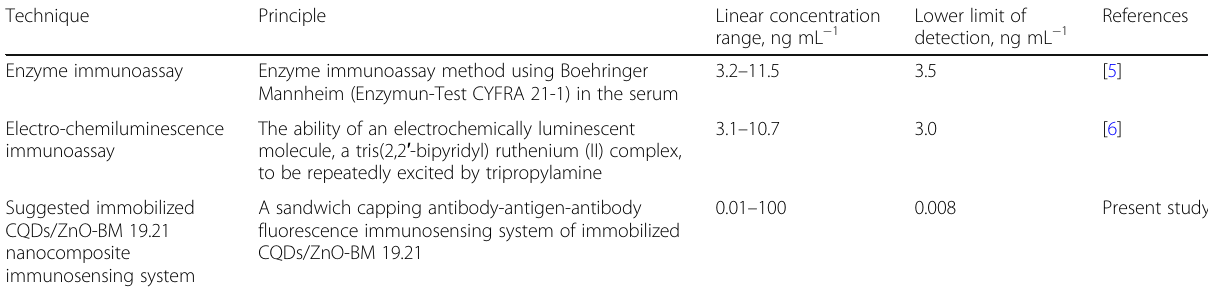
Table 1 A comparative study between the suggested immobilized CQDs/ZnO-BM 19.21 nanocomposite fluorescence immunosensing technique and previously published techniques Technique